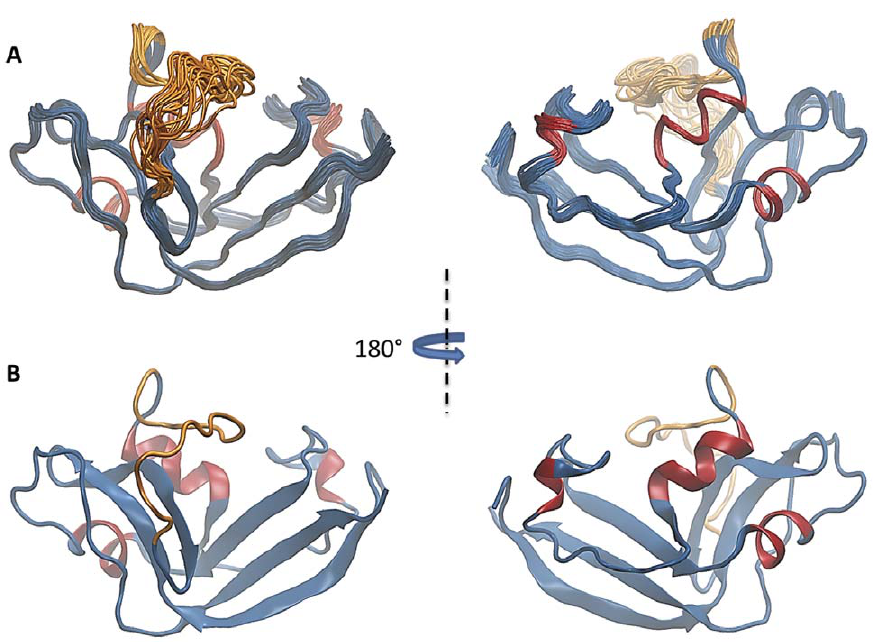
Figure 3. 3D structure of ONCFLG by NMR. (A) Backbone superposition of the 20 lowest energy conformers of ONCFLG. The disordered linker segment (Gly33-Gly48) is represented in orange and the rest of the protein backbone sequence in blue except for the a -helices which are in red. The views are rotated 180 u with respect to each other. (B) Ribbon drawing of a representative conformer of the energy-minimized family of ONCFLG variant structures. Colors and the orientation are the same as in (A). This figure was generated by VMD [41].